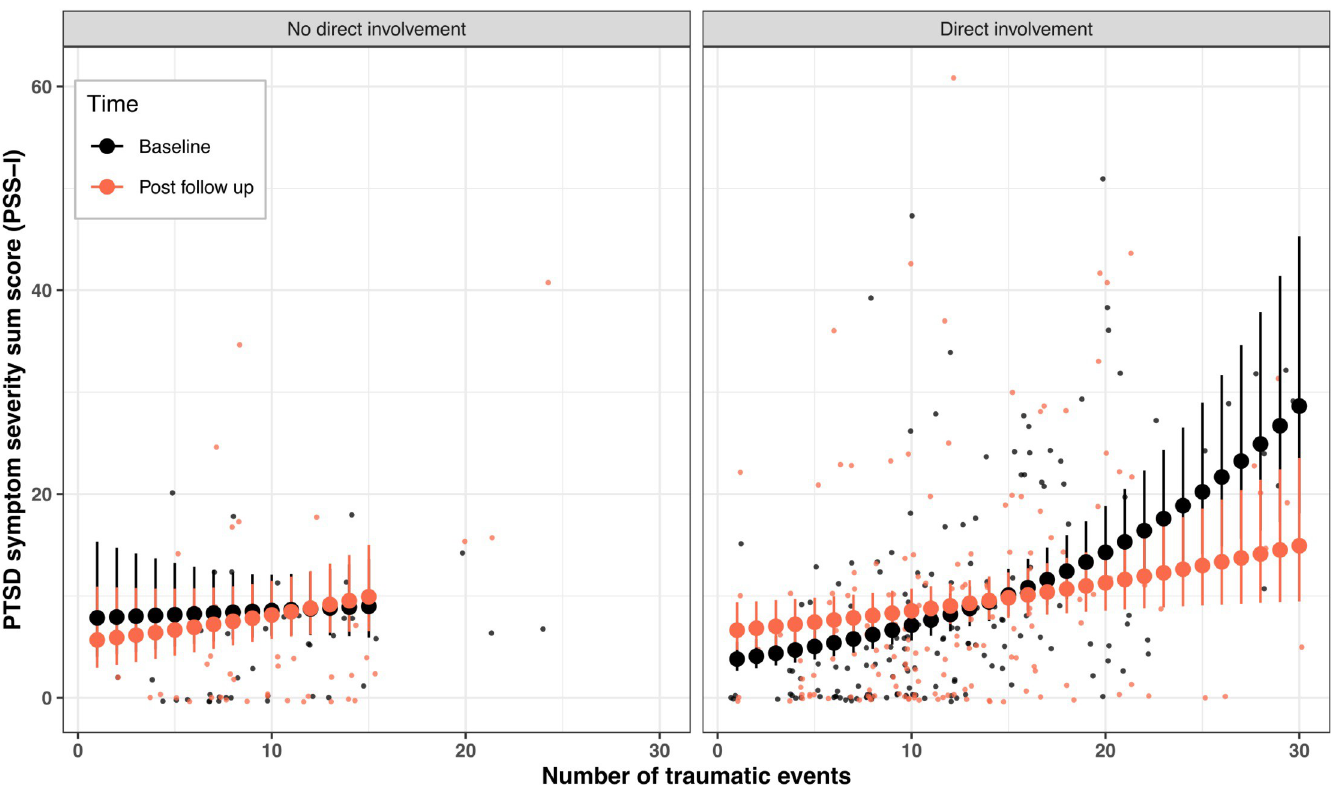
Fig 3. Significant interaction effect of the number of traumatic events among participants with no direct vs direct involvement in NETfacts from baseline to post follow up (time marked in color) on PTSD symptom severity. Small dots represent real individual observations, whereas large dots and error bars show mean estimates with 95% confidence intervals produced by the GLMM. Large dots and error bars for no direct involvement are presented up to 15 traumatic events due to small sample size.